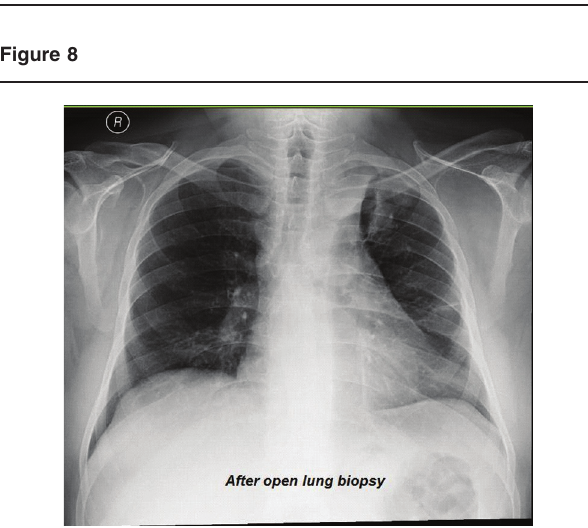
Postoperative plain chest radiography.